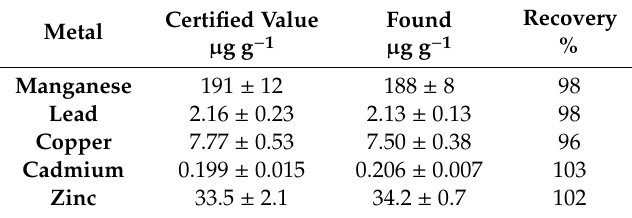
Table 2. Metals concentration in the certified reference material ( p = 0.95; n =